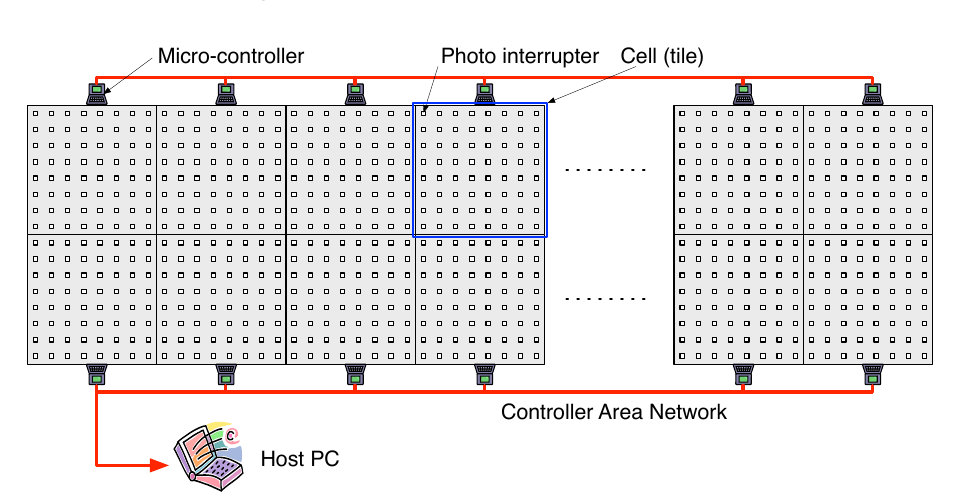
Figure 3. Overall structure of